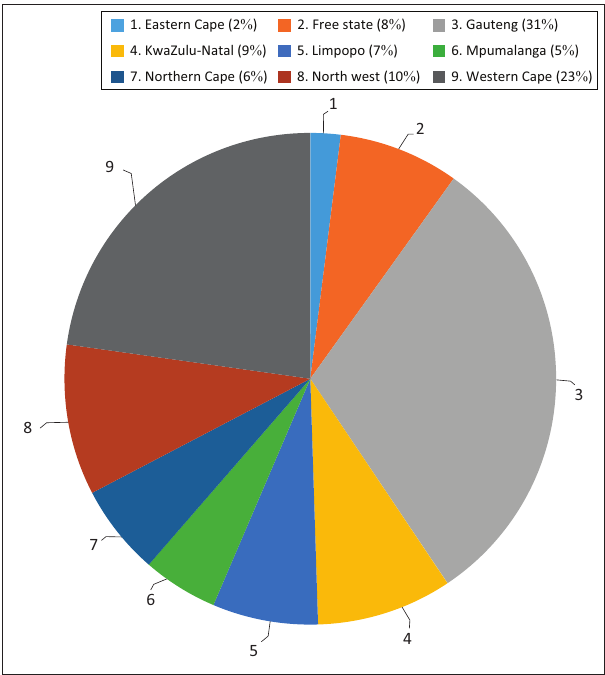
FIGURE 1: Respondents’ distribution according to